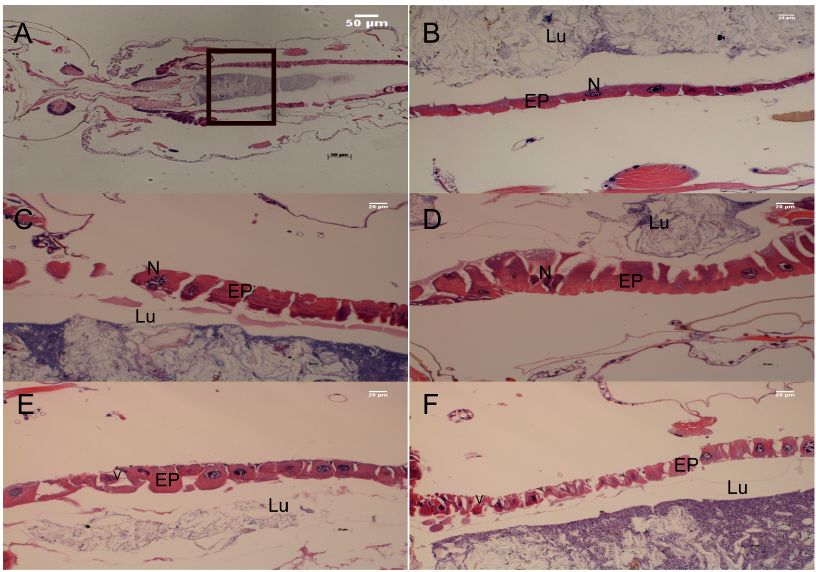
Figure 4. Photomicrographs of the midgut of Culex pipiens pallens third-instar larvae (magnification 20×). ( A , B ) control; ( C , D ) from a larva treated with Perilla frutescens essential oil (PE-EO; LC50, LC90); ( E , F ) from a larva treated with 2-hexanoylfuran (LC50, LC90). EP: Epithelial cells, N: nucleus, LU: gut lumen, V: vacuoles.